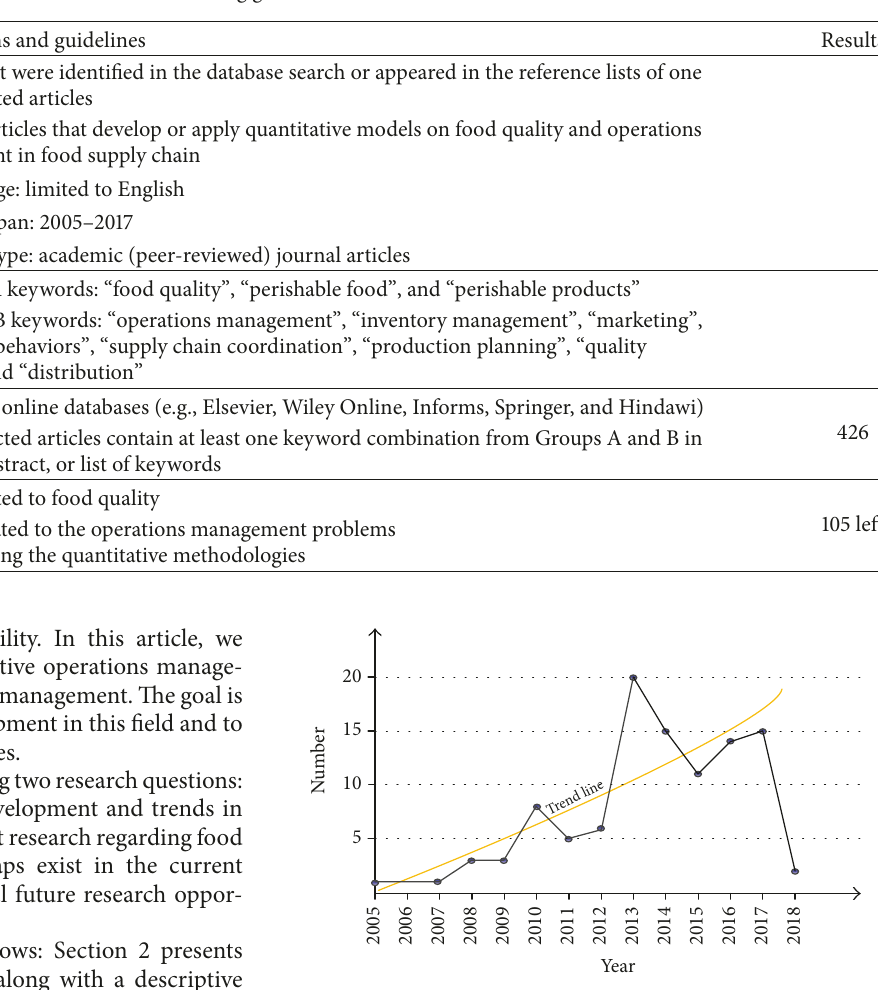
Figure 1: Distribution of articles over